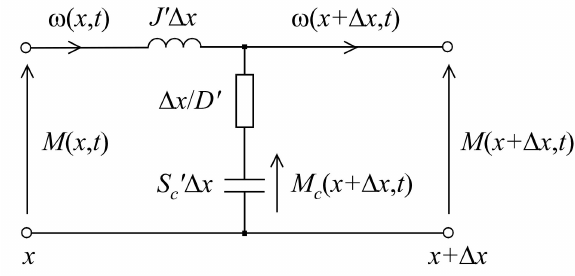
Figure 3. Equivalent circuit of a transmission shaft